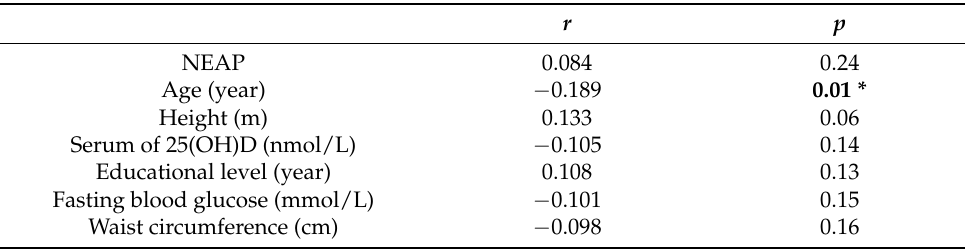
Table 2. Correlations between selected sociodemographic background, anthropometry parameters, biochemical indices, and NEAP with CTX1 among the participants.